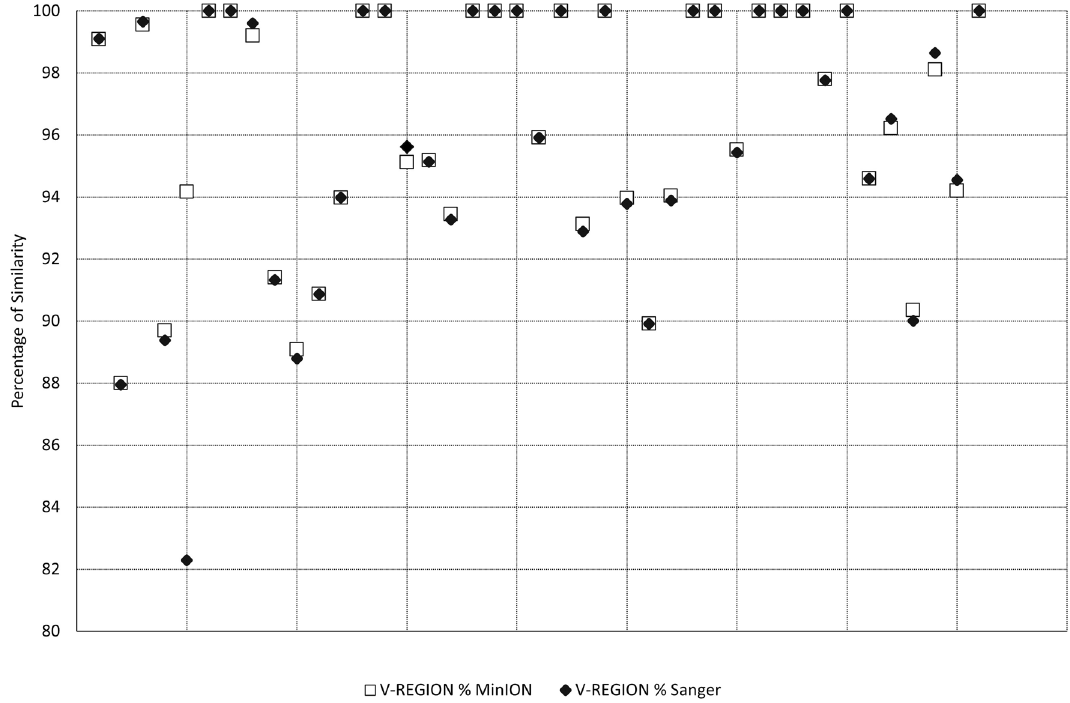
Figure 4. Comparison between the VH region percentage of similarity as obtained from IMGT/V-Quest analysis. Data from SS and MinION for each specific VH and sample are compared. VH that were found only in SS analysis or MinION analysis are excluded from the